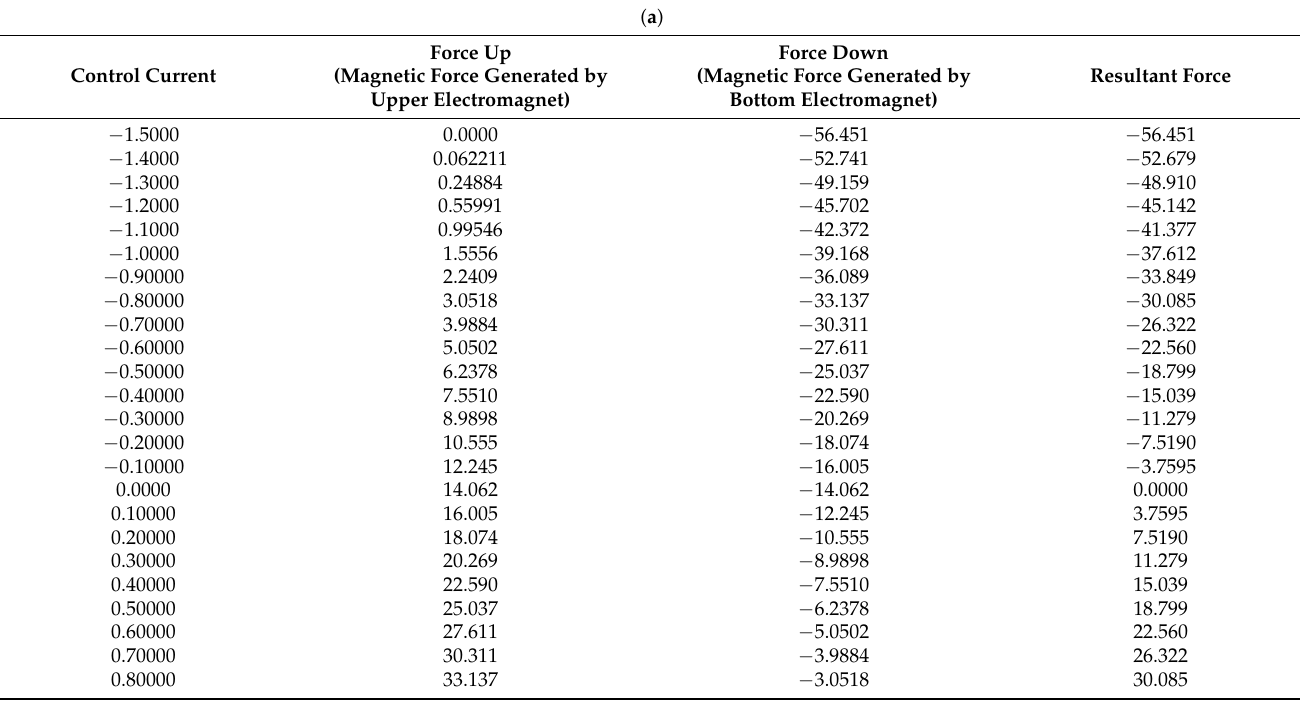
Figure 12. Magnetic forces for the nominal position of the shaft raceway in the air gap ( a ) and the current of the working point ( b ). Table 2. Magnetic forces for different control currents (Figure 12a) ( a ); magnetic forces for different displacements (Figure 12b) ( b ).